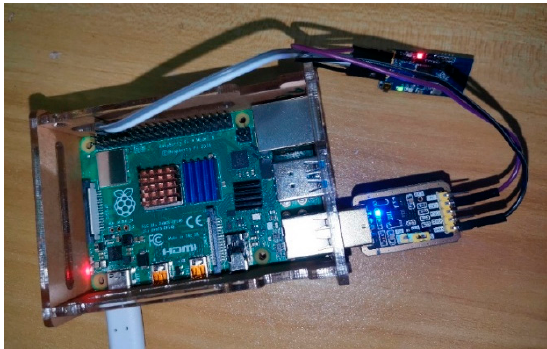
Figure 20. Algorithm evaluation on Raspberry Pi 4B+.